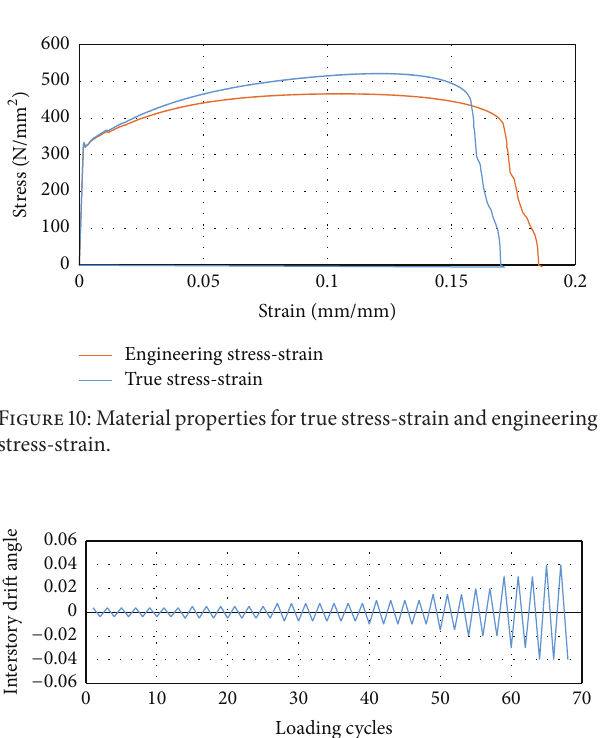
Figure 11: The loading protocol used for seismic assessment [12]. Continue loading at increments of 𝜃 = 0.01 radians, with two cycles of loading at each